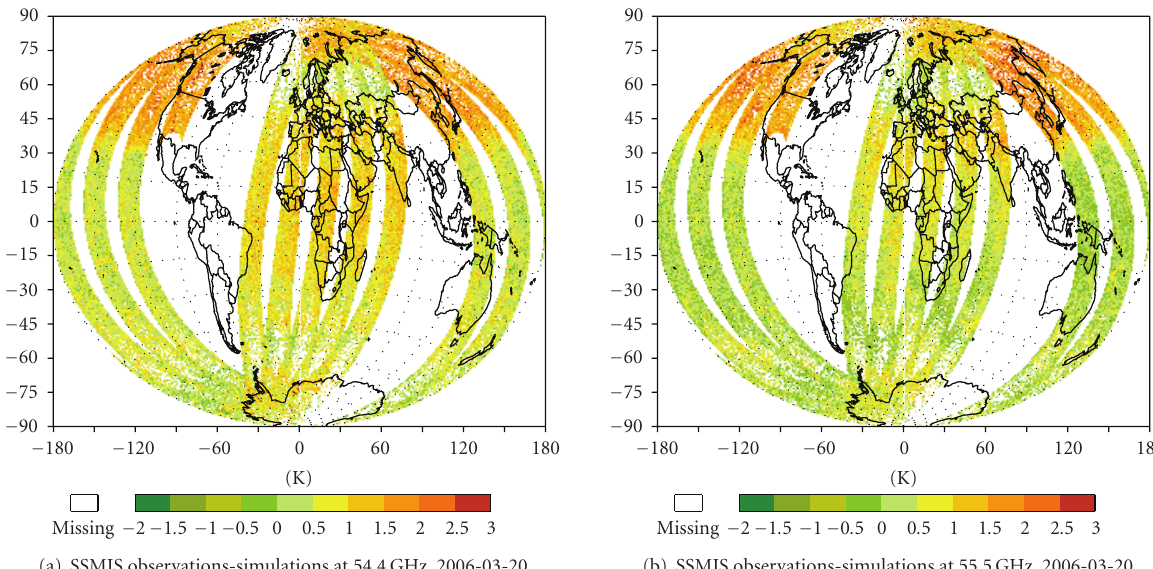
Figure 8: Global distribution of antenna temperature bias between SSMIS TDR measurements and radiative transfer simulations on March 20, 2006 for (a) 54.4 GHz, and (b) 55.5 GHz.